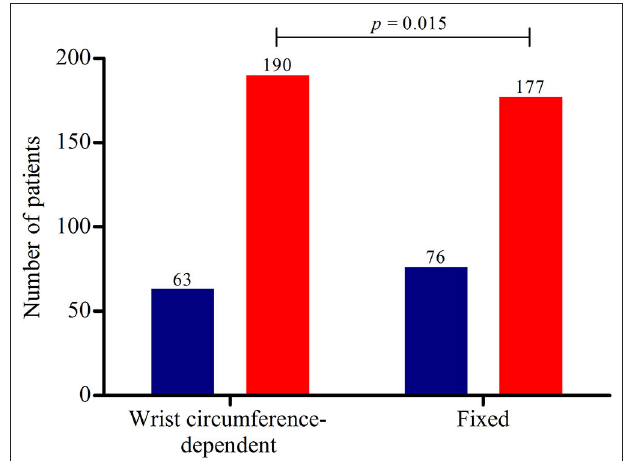
FIGURE 4 | Ultrasound results of the 253 patients. The red bars represent the number of patients with abnormal ultrasonography results and the blue bars normal ultrasonography results. Using a wrist-circumference dependent upper limit of normal (ULN), 190 patients (75.1%) had abnormal US results vs. 177 patients (70.0%) using a fixed ULN of the cross-sectional area of the median nerve of 11 mm 2 ( p = 0.015). The mean CSA of these 190 and 177 patients with abnormal US results were 14.9 ( ± 4.1) and 15.2 ( ± 4.1), respectively, without a statistically significant difference ( p =